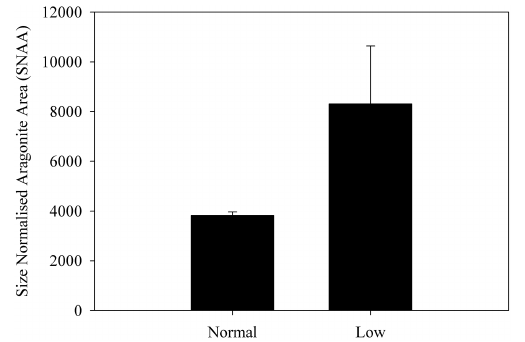
Figure 8. Size-normalised aragonite area (SNAA). Normal=pH n - shells, low=pH low -shells.